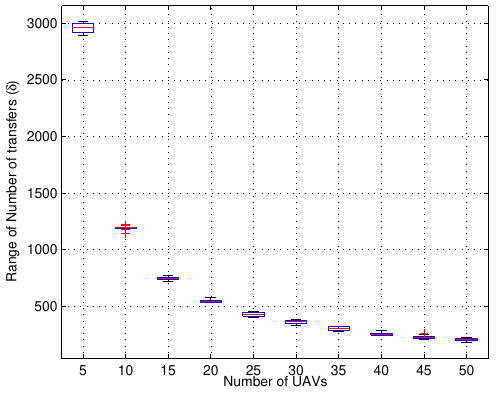
Figure 9. Range of Number of transfers vs. number of UAVs at a fixed number of failures.